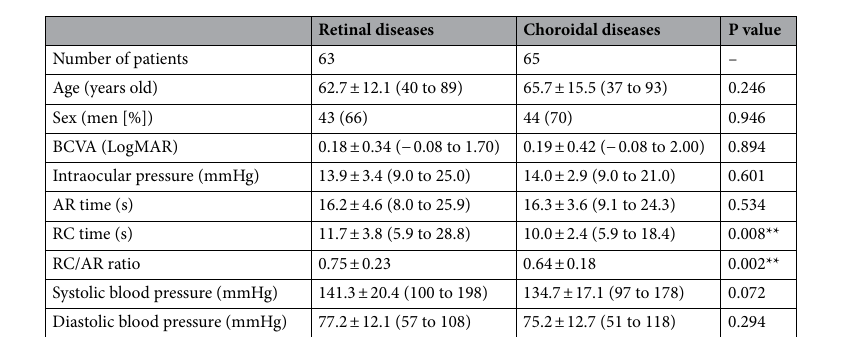
Table 2. Differences in the patients with retinal diseases and choroidal diseases. Data are shown in mean ± standard error (range). AR time arm-to-retina time, RC time retinal circulation time, RC/AR ratio RC time/AR time ratio. **P <